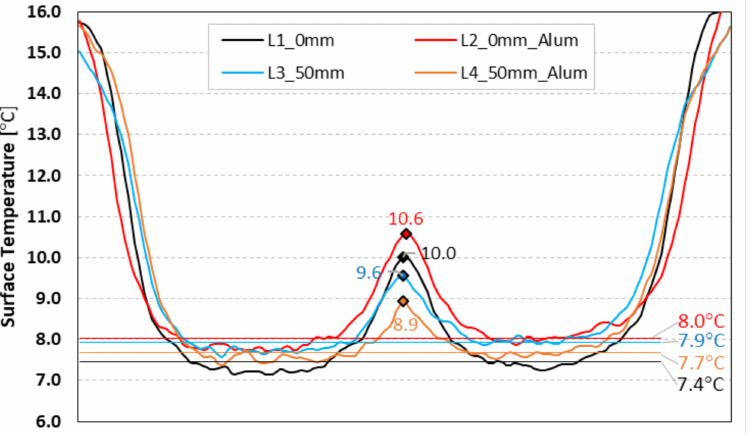
Figure 8. Horizontal temperature lines from infrared images of the double pane LSF walls, with and without reflective aluminium foil, for two air cavity’s thicknesses (0 and 50 mm), on the cold surface.